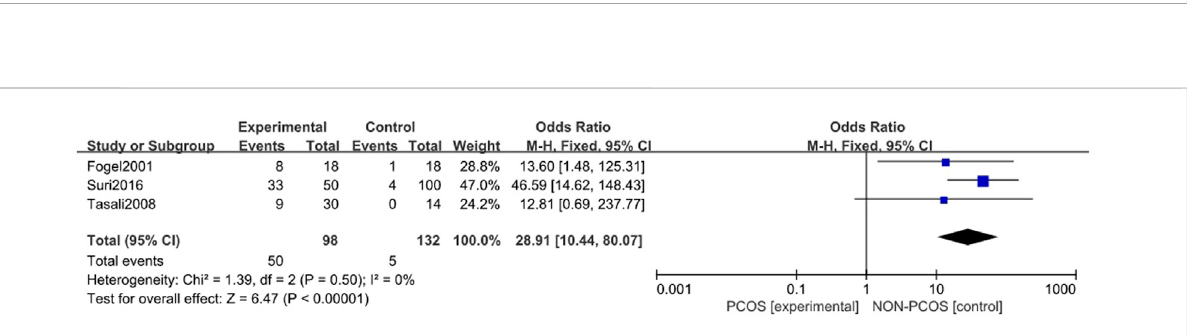
Forest plot of the incidence of sleep disturbance in the PCOS group and the control group (before heterogeneity was excluded).